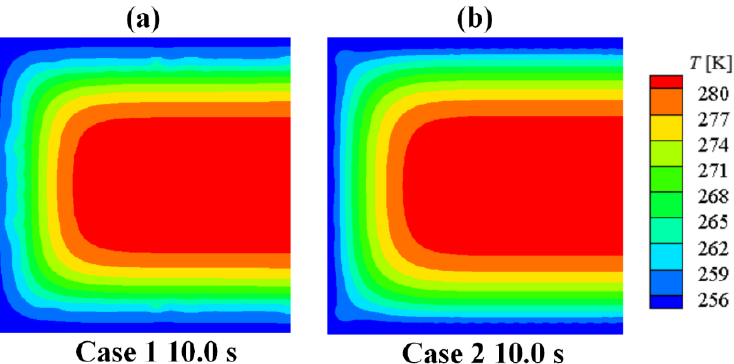
Figure 9. Comparison of temperature distribution (K) in both cases at t = 10.0 s ( a ) Case 1 and ( b ) Case 2.